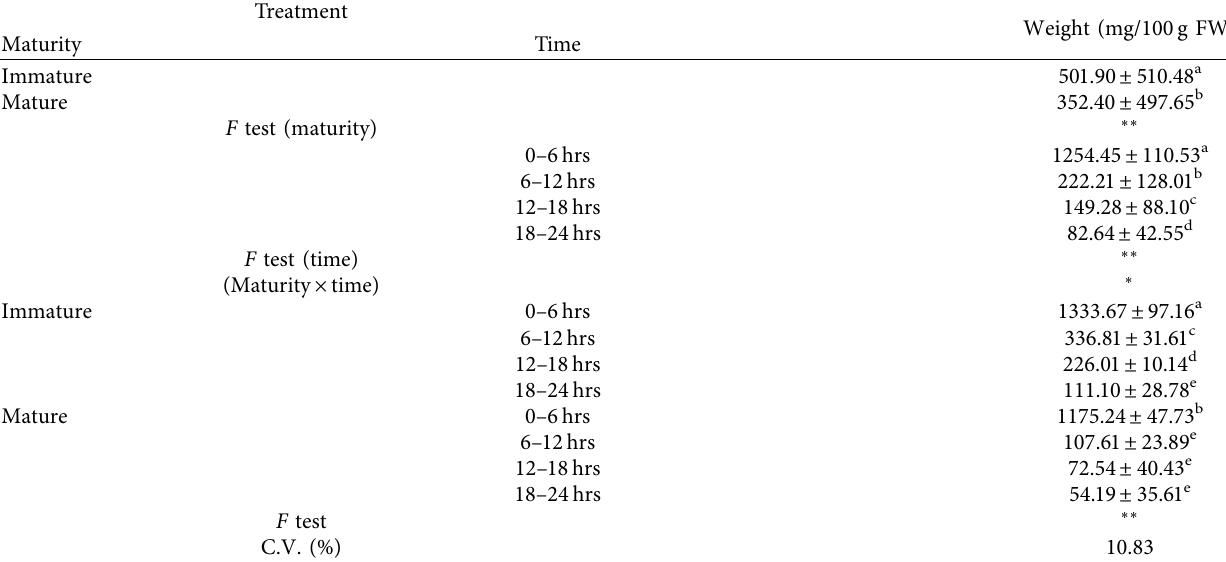
Table 1: Yields of essential oils extracted from immature and mature leaves of B. balsamifera with diferent hydrodistillation periods.